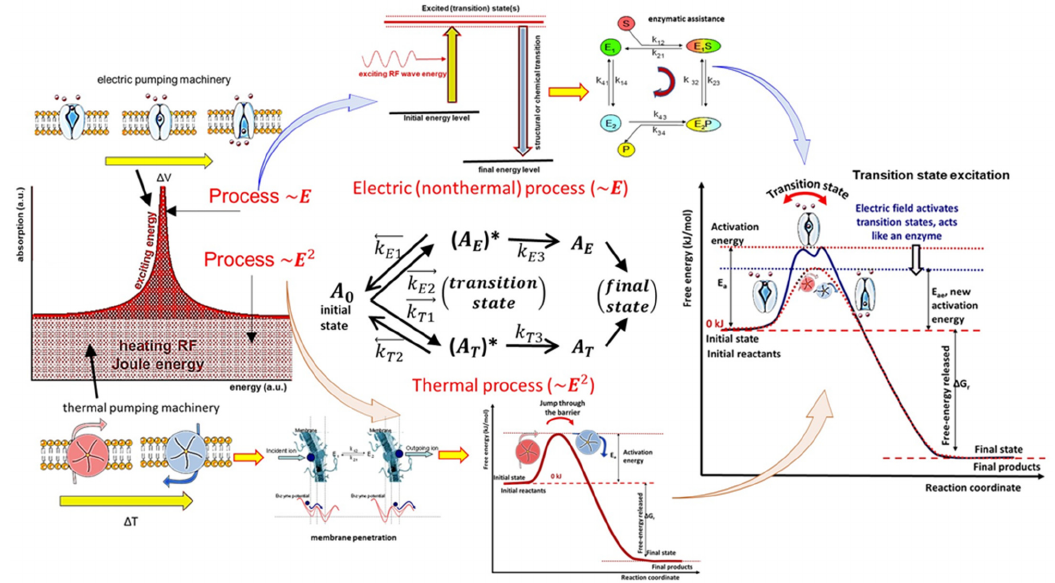
Figure 12. The measured thermal and nonthermal effects of mEHT. The thermal effect has an Arrhenius character, while the nonthermal effects are quantum-mechanical, promoting enzymatic processes, pushing through the transitional state. The nonthermal processes use the thermal conditions for optimal reaction rates. (For details, see in the text.). The * denotes metastable transitional state.